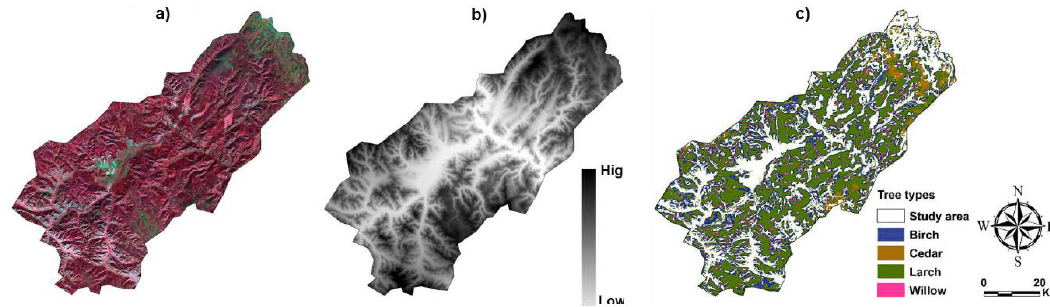
Figure 3. ( a ) Landsat 8 surface reflectance image in false color, ( b ) ASTER GDEM, and c) Forest